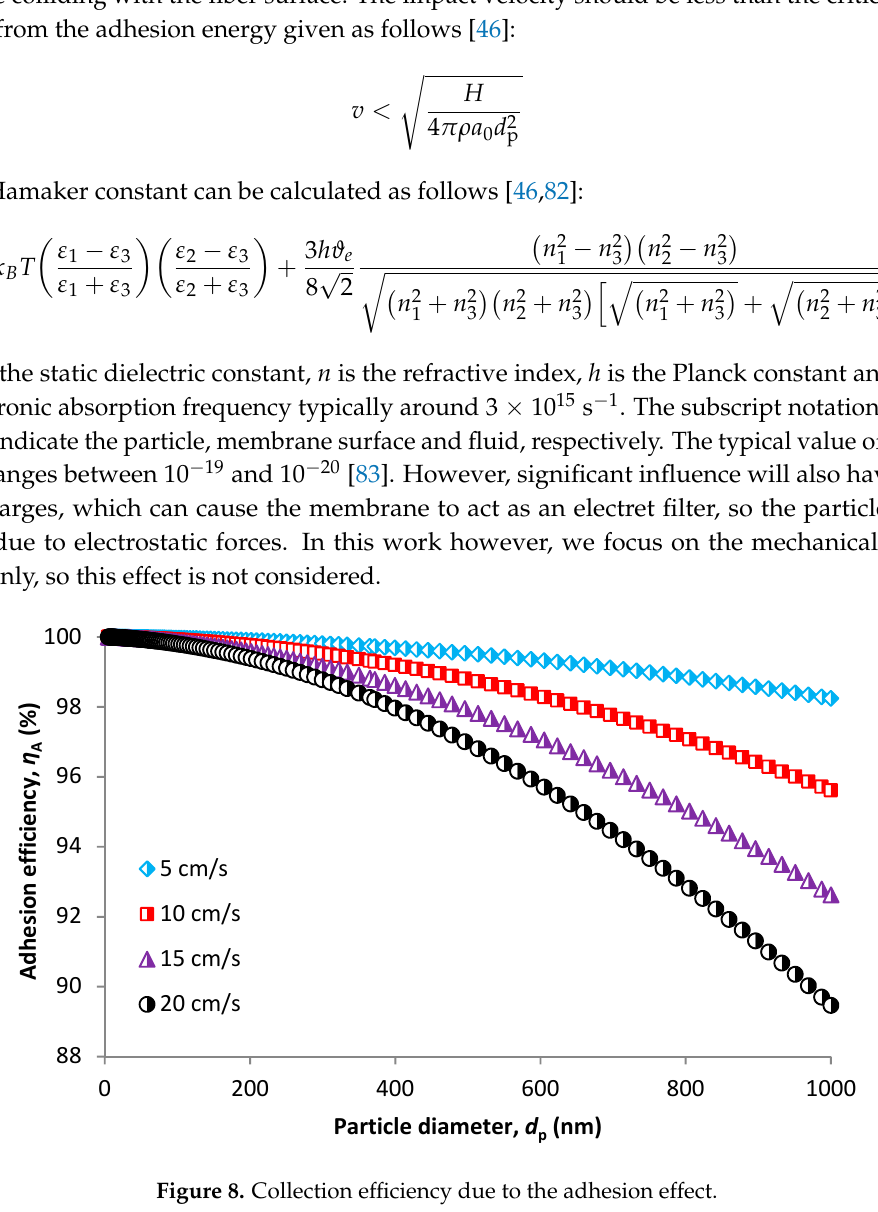
Figure 8. Collection efficiency due to the adhesion effect.